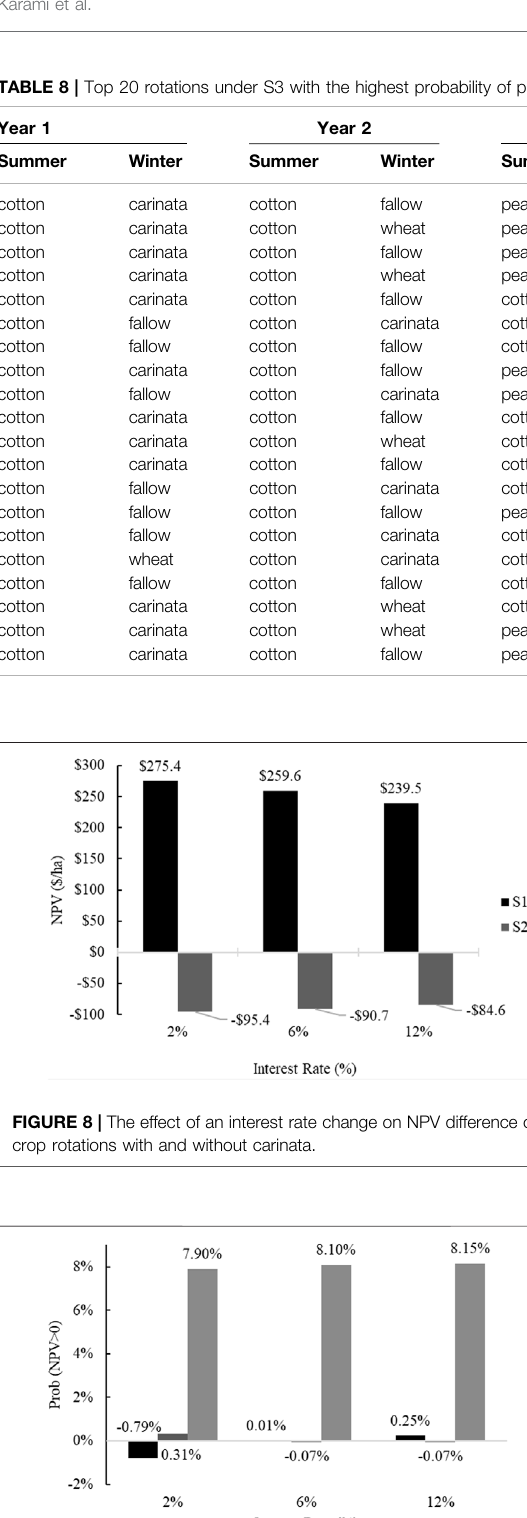
Frontiers in Energy Research |